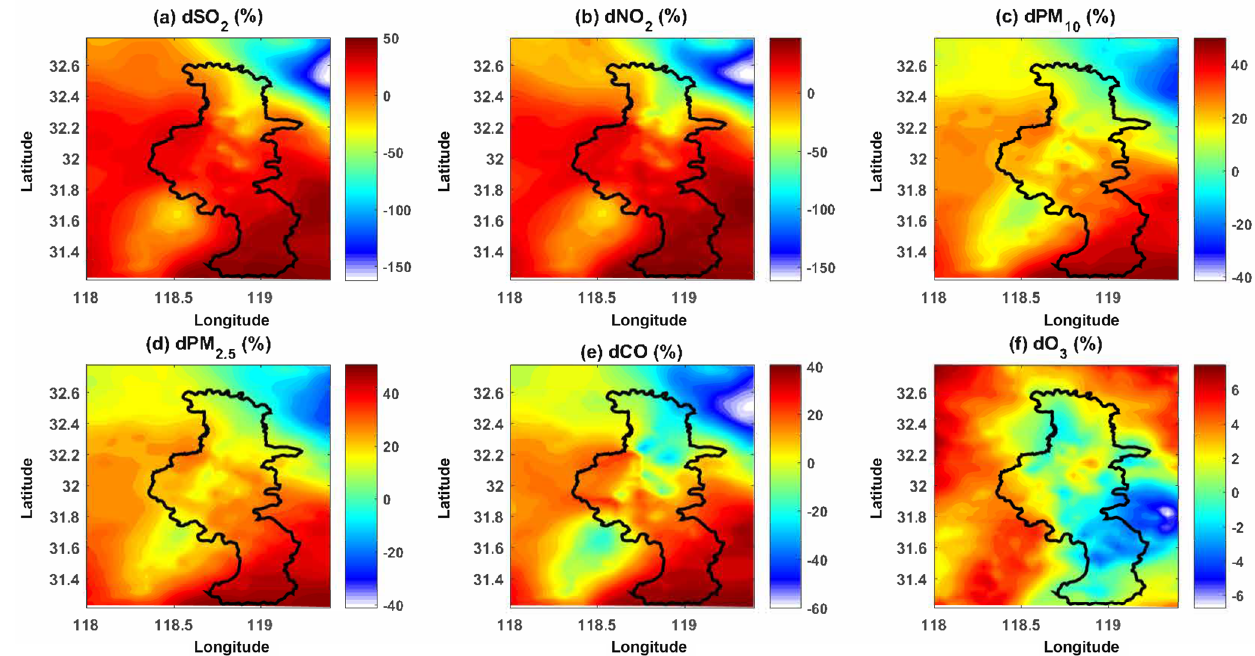
Figure 7. Influence of meteorology on hourly mean concentrations of air pollutants in August 2014 compared with Au- gust 2013. Black thick lines outline Nanjing. Panels (a–f) are hourly average values of impact percentage (dspecies (%) = (Experiment 2 − Experiment 3) / Experiment 2 × 100%) of SO 2 , NO 2 , PM 10 , PM 2 . 5 , CO and O 3 .